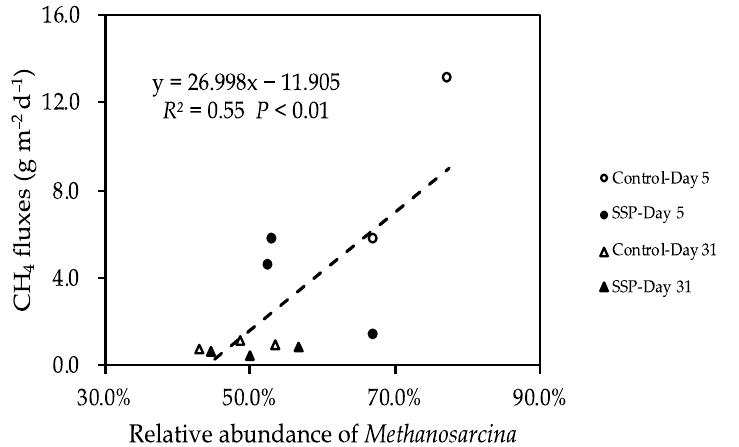
Figure 6. Dependence of CH 4 fluxes on the relative abundance of Methanosarcina in the compost for different treatments. Treatments were defined as in Figure 1.